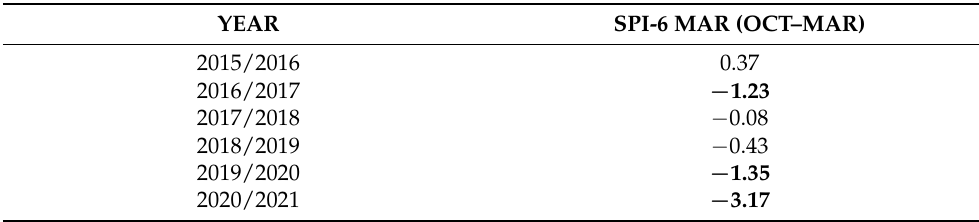
Table 5. March SPI-6 values within the hydrological drought event (identified by SPI-12) from 2016 to 2021. The years marked in bold were characterized by moderate or extreme drought conditions (identified by SPI-6).